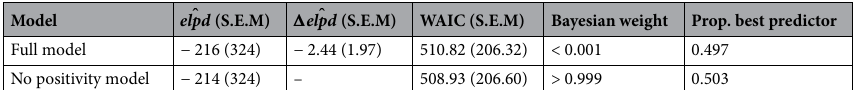
This may either be because, for a subset of participants, positivity affected the perceived credibility of psychics, or because estimated values of the additional parameter ( k Pos , corresponding to the extent to which positivity